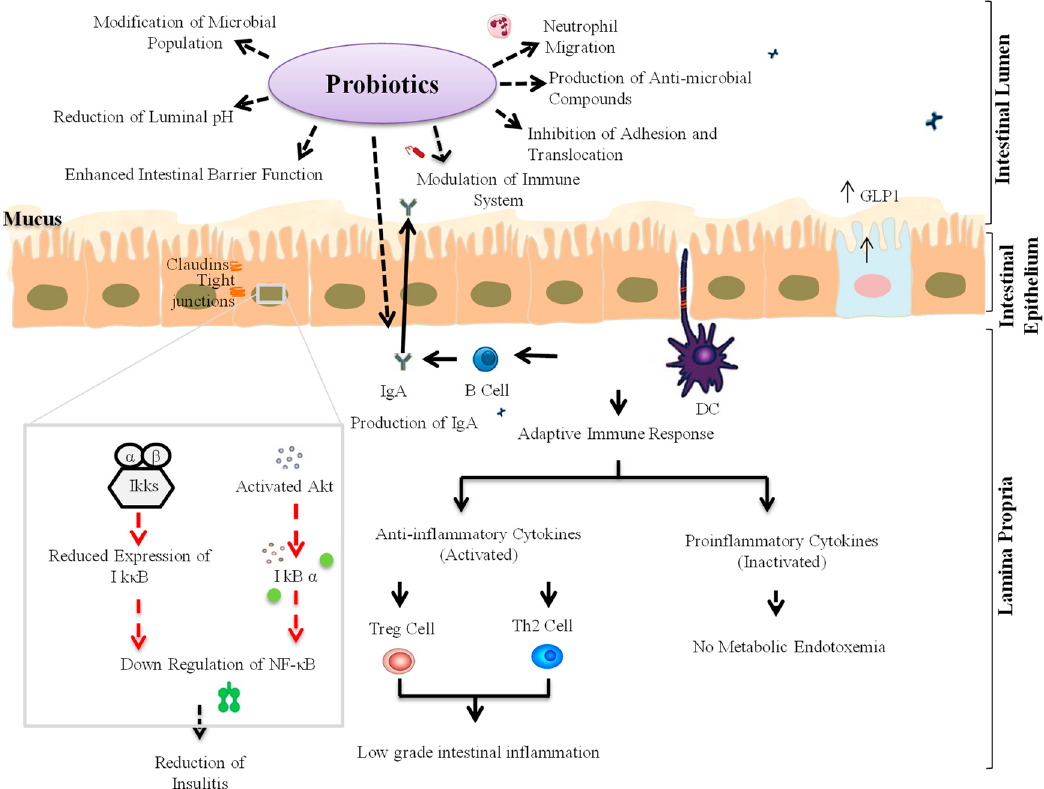
Figure 3. Schematic representations of mechanisms of actions through which specific probiotic strains might help in the amelioration of T1D. Akt: protein kinase B; DCs: Dendritic cells; GLP-1: Glucagon-like peptide-1; NF- κ B: Nuclear factor kappa-light-chain-enhancer of activated B-cells; I κ B α : I kappa B kinase; IkkB: I κ B kinase beta; IgA: Immunoglobulin A; Treg: T regulatory cell; Th2: T-helper cell 2.